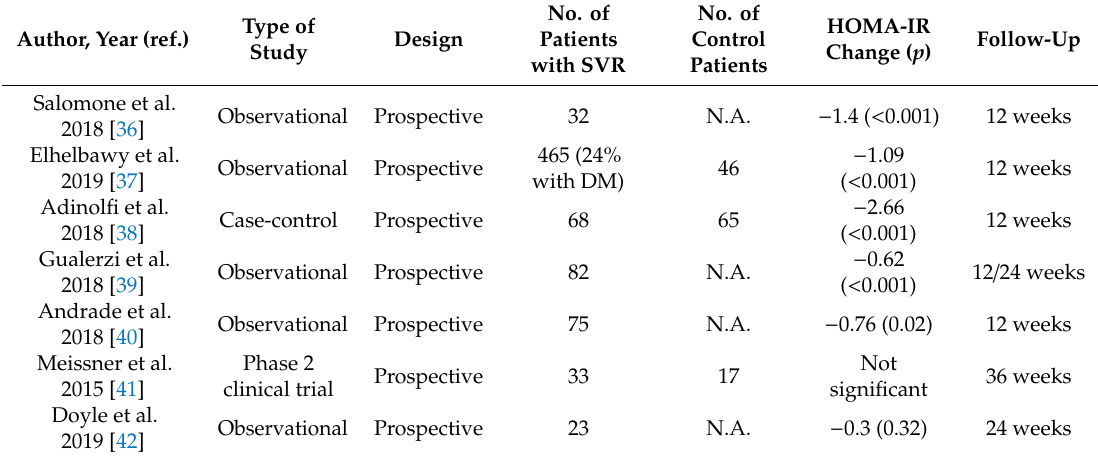
Table 1. Impact of DAA treatment on insulin resistance in nondiabetic HCV